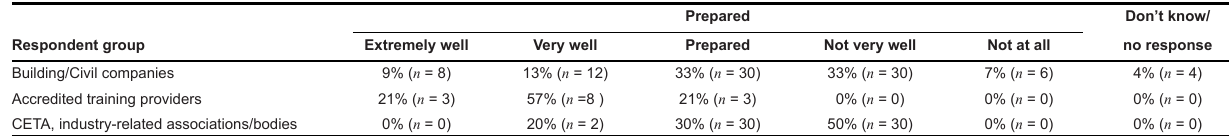
TABLE 4 Overall provider learnership competence – across all